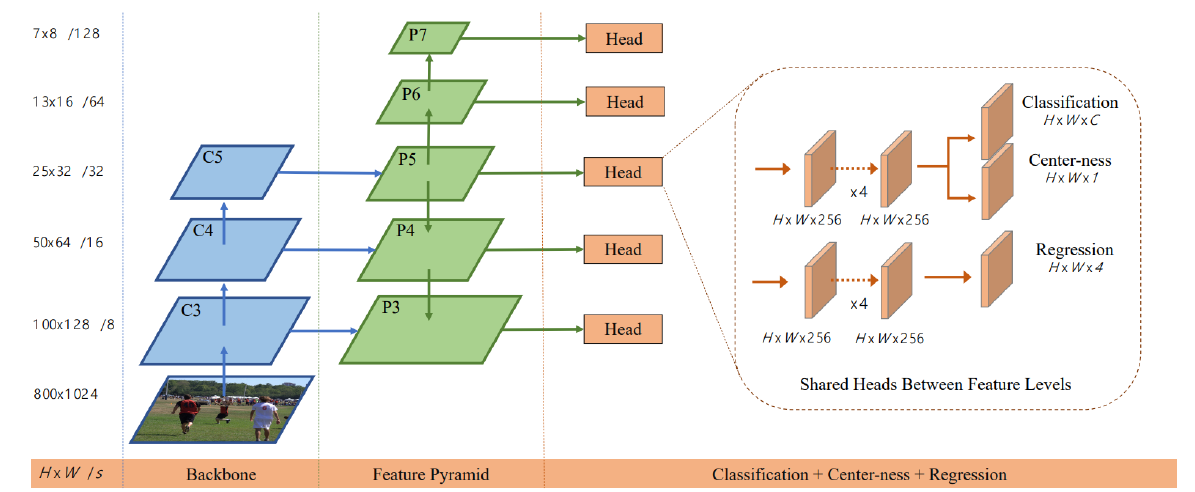
Figure 1. FCOS network